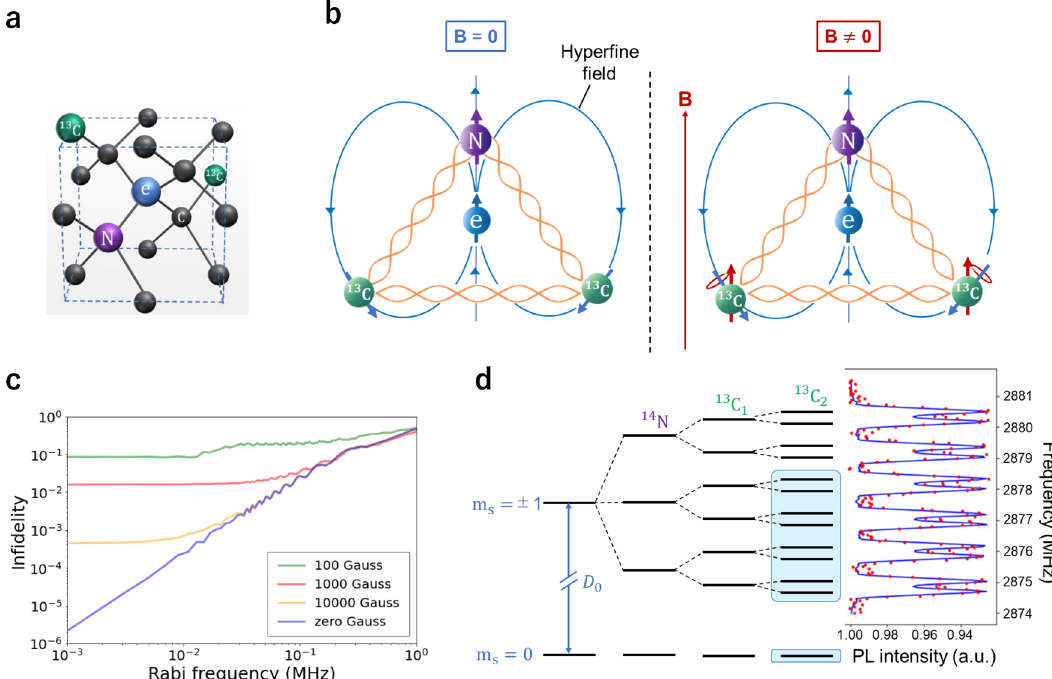
Fig. 1 Carbon spin manipulation with and without magnetic fi eld. a Schematic structure of a nitrogen-vacancy center in diamond, where carbon (C) adjacent to a vacancy (e) is replaced by impurity nitrogen (N), whose spin error is protected by two carbon isotope spins serving as ancilla qubits for quantum error correction. The green-colored 13 C atoms ’ placement is just an artistic choice. b Quantization axis of carbon nuclear spins, which is determined by the hyper fi ne fi eld by the electron spin as well as the external magnetic fi eld if applied. c Simulated Rabi frequency dependence of the fi delity (F) of the holonomic controlled-phase gate based on the geometric phase between two carbon nuclear spins ( 13 C 1 , 1.14 MHz; 13 C 2 , 0.33 MHz) under a zero magnetic fi eld (blue line), 100 Gauss (green line), 1000gauss (red line), and 10000 Gauss (orange line). The angle between the external and hyper fi ne magnetic fi elds is set at 45 degrees for both carbon nuclear spins. Under a magnetic fi eld, the fi delity is limited by the in fl uence of the two quantum axes, but under a zero magnetic fi eld, the fi delity improves by decreasing the Rabi frequency. The nitrogen nuclear spin is not considered here because the quantization axis does not change with the presence of a magnetic fi eld. d Energy level diagram of the relevant spin system containing one nitrogen and two carbon isotopes together with an optically detected magnetic resonance spectrum relating to the |0 ⟩ s − |±1 ⟩ s transition. PL denotes photoluminescence. D ¼ 2 : 877 MHz is the zero- fi eld splitting. Hyper fi ne splittings are observed ( 14 N,2.2MHz; 13 C 13 C 1 ,1.14 MHz; 2 ,0.33 MHz). The energy levels inside the blue 0 rectangles are used in this